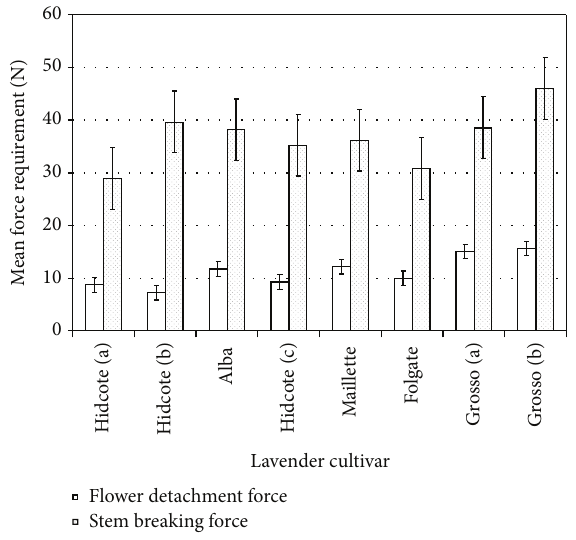
Figure 5: Mean flower detachment force and stem tensile failure force for eight lavender crop samples showing overall mean of 95% confidence